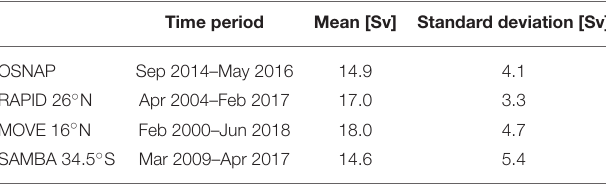
TABLE 1 | Basic statistics for the time series of AMOC strength at the four latitudes where the time series are